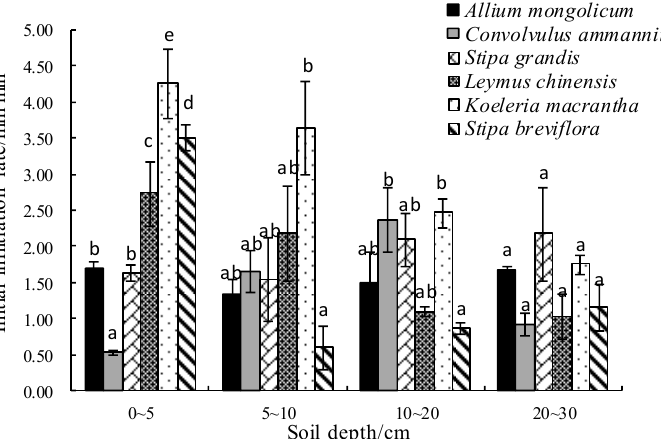
Figure 2. Soil IIR under different vegetation communities. Note: different letters (a,b,c,d,e) indicate significant differences ( p < 0.05) among different plant communities.